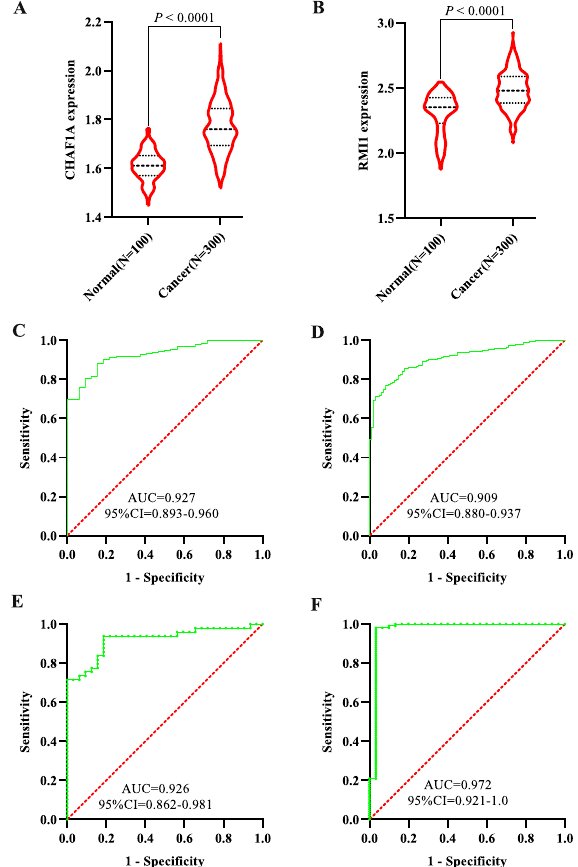
( A ) and RMI1 ( B ) in the GSE66229 cohort; The ROC curves of the two genes-based diagnostic classifier in the TCGA cohort ( C ) and the independent GSE66229 cohort ( D ); ROC curves of the diagnostic classifier for stage